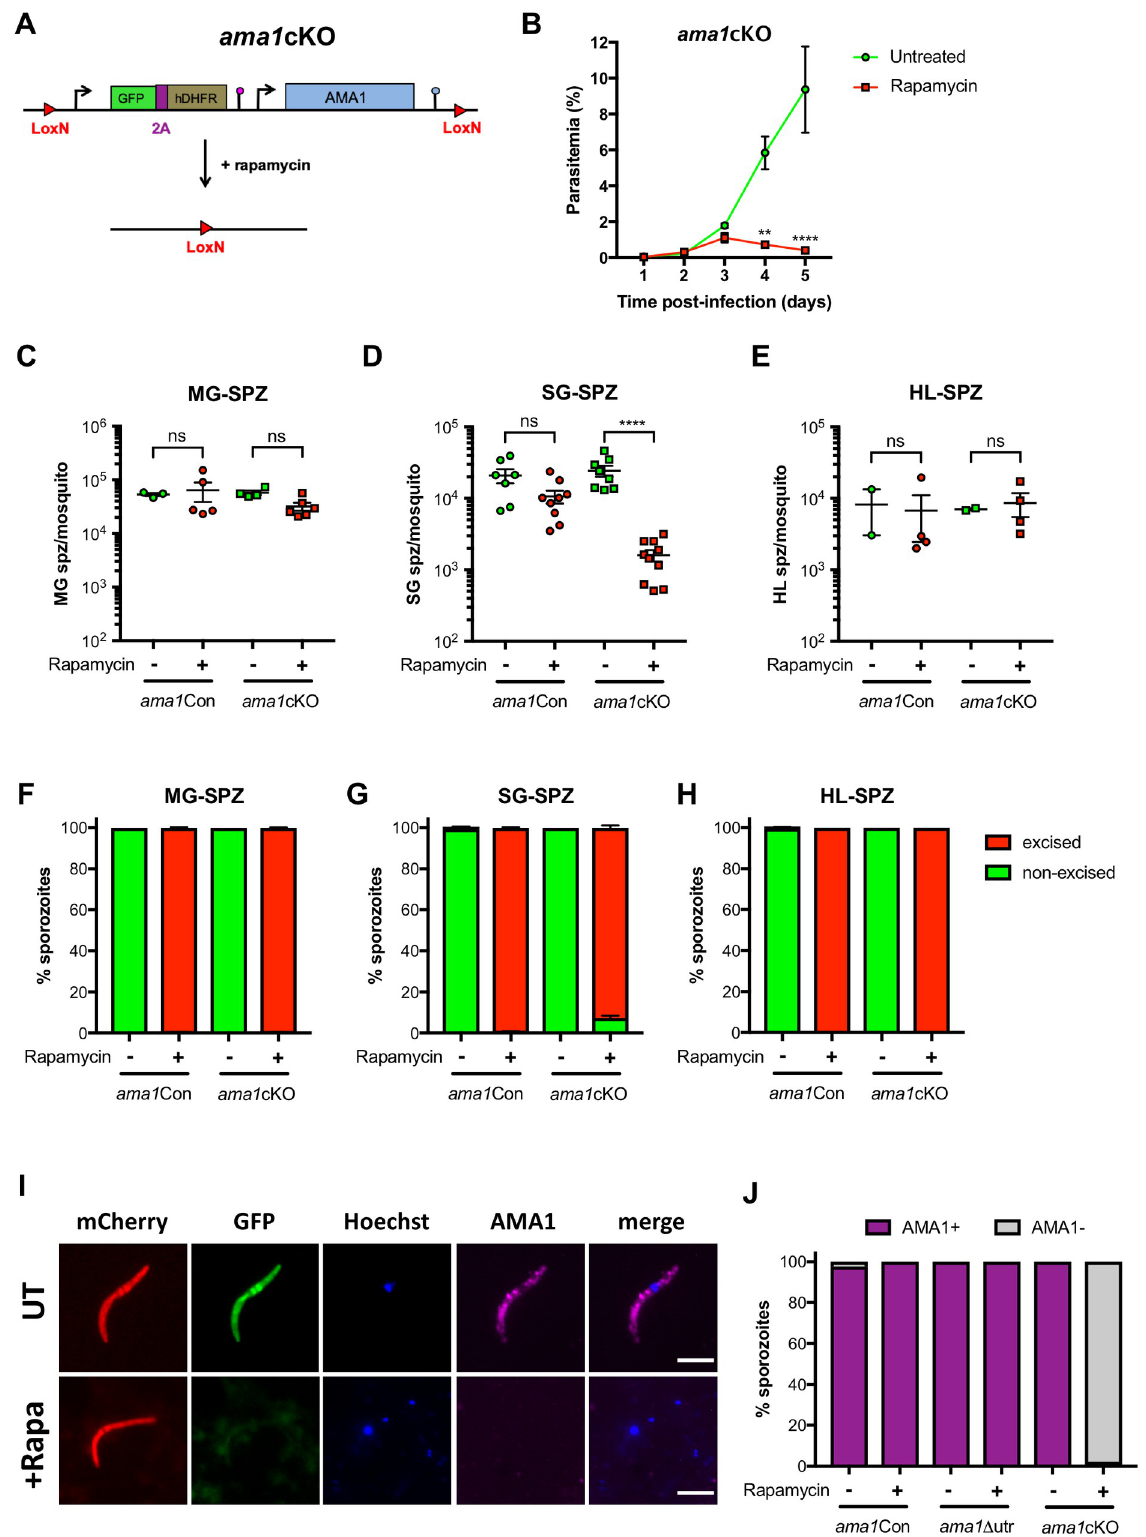
Fig 2. AMA1 is required during P . berghei invasion of mosquito salivary glands. A. Strategy to generate ama1 cKO parasites by modification of the ama1 locus in rapamycin-treated ama1 Con parasites. B. Blood stage growth of rapamycin-treated and